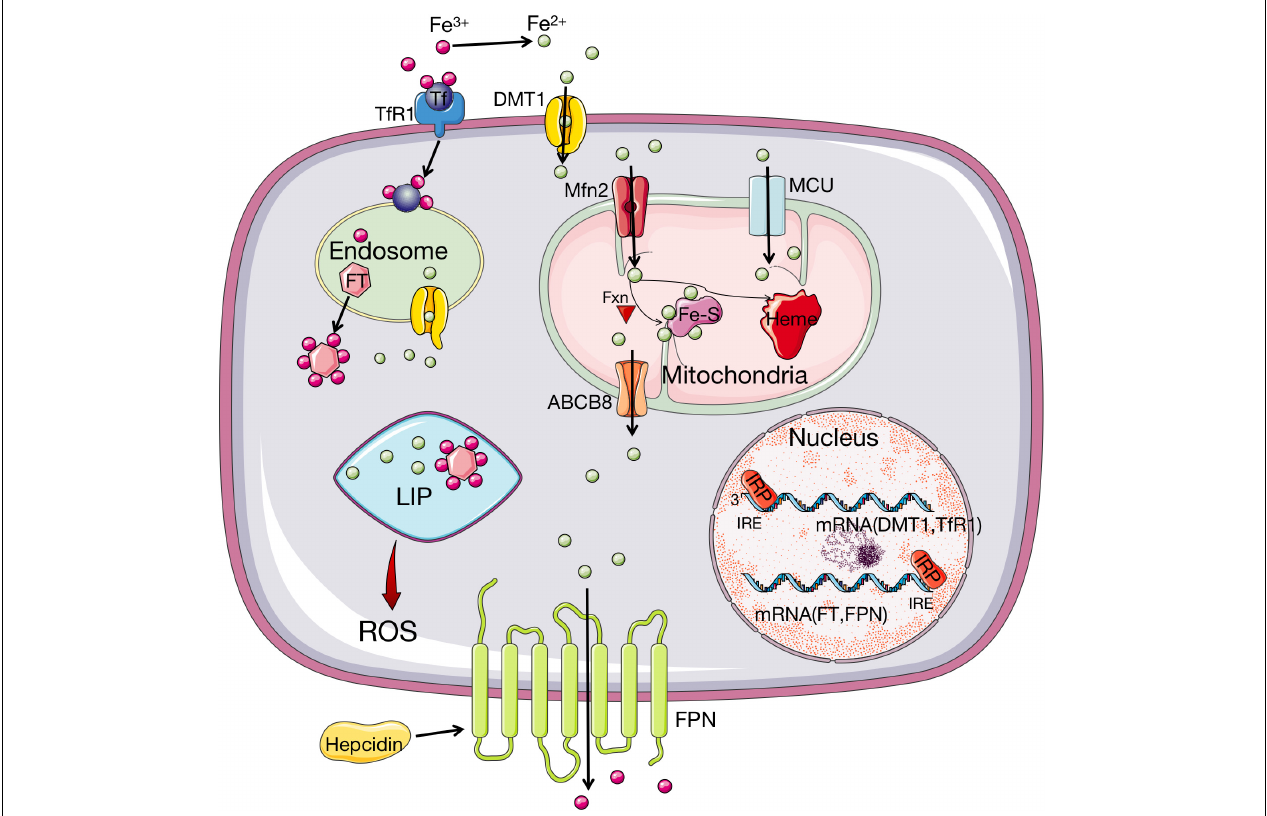
FIGURE 1 | Iron metabolism and homeostasis in organism. Fe 3 + is imported into cells through Tf recognized by TfR1 while the uptake of Fe 2 + is implemented through DMT1. Then Fe 3 + is converted to Fe 2 + in endosome, which is released from endosome by DMT1. In cell, iron is stored by binding FT, with a small amount staying at LIP. When the amount of iron in LIP increases to the homeostatic limits, ROS will be produced. The transport of iron to mitochondria is via MFRN and MCU. In mitochondria, iron can be synthesized to heme, or Fe–S under the participation of Fxn. The export of iron from mitochondria is through ABCB8 transporter and from cells is mediated through FPN. FPN can oxidize Fe 2 + to Fe 3 + , which is regulated by hepcidin. Iron homeostasis is controlled by IRP1/2, which can bind to IRE sites of mRNA of DMT-1, TfR1, FT, and FPN to regulate the influx and efflux of iron depending on the iron availability. When the intracellular iron level is low, IRPs bind to the 3 (cid:48) UTR site of the mRNA of DMT1 and TfR1 to stabilize their transcript, whereas the 5 (cid:48) UTR site mRNA of FT and FPN is also bound by IRPs to inhibit translation. Fe 3 + , ferric; Tf, transferrin; TfR1, transferrin receptor 1; Fe 2 + , ferrous; DMT1, divalent metal transporter 1; FT, ferritin; LIP, labile iron pool; ROS, reactive oxygen species; MRFN, mitoferrin; MCU, mitochondrial calcium uniporter; Fe–S: iron–sulfur cluster; Fxn, frataxin; FPN, ferroportin; ABCB8, adenosine triphosphate (ATP)-binding cassette subfamily B member 8; IRP1/2, iron regulatory protein 1/2; IRE, iron responsive